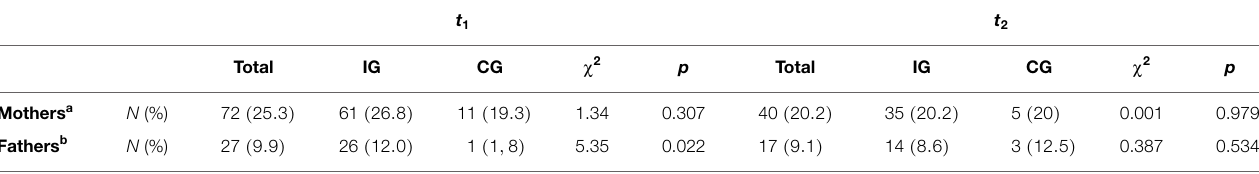
TABLE 4 | Numbers and percentages of psychological distressed parents at t 1 and t 2 according to midwifes’ judgments and inferential statistics